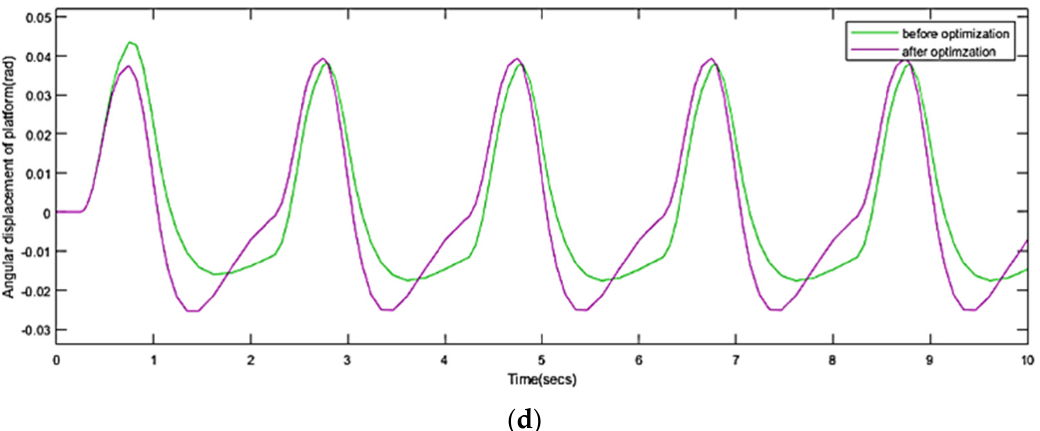
Figure 15. Value of optimization target before and after optimization: ( a ) displacement; ( b ) soma- tosensory acceleration error; ( c ) angular displacement; ( d ) somatosensory angular velocity error.